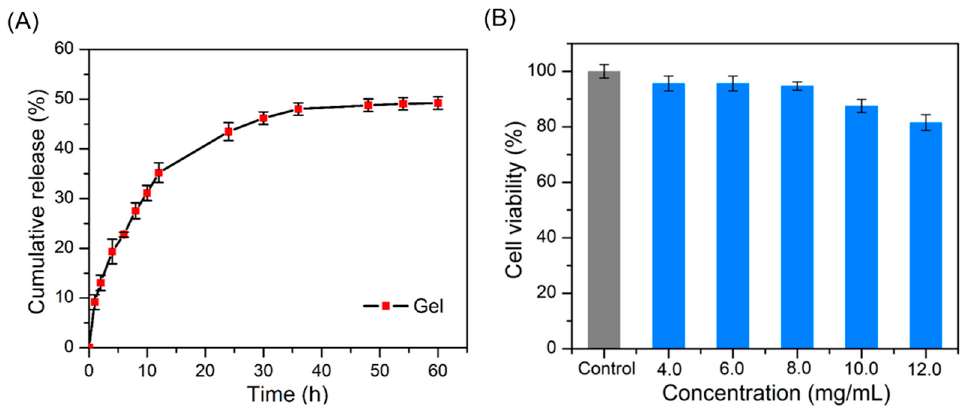
Figure 4. ( A ) In vitro release pro fi le from ZW/GDL hydrogel incubated with PBS solution (pH 7.4) at 37 °C. ( B ) Cell viability of L929 fi broblasts incubated with di ff erent concentrations of hydrogel for 37 ◦ C. ( B ) Cell viability of L929 fibroblasts incubated with different concentrations of hydrogel for 24 24 h.